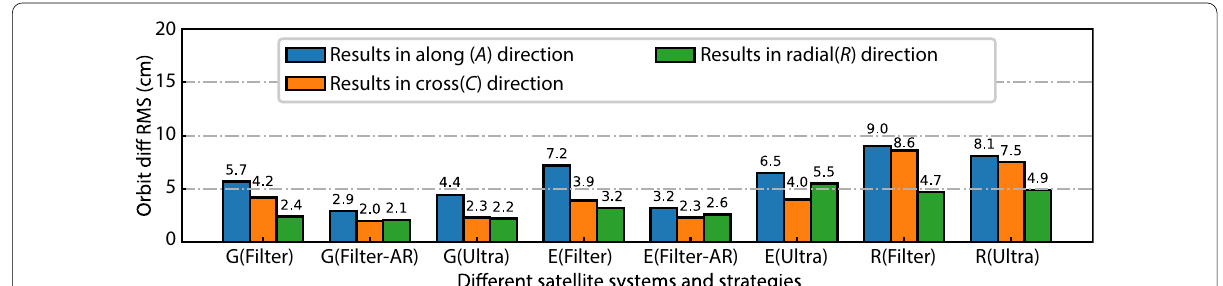
Fig. 5 Average orbit accuracy of filtering solutions and ultra-rapid products for GPS, Galileo, and GLONASS satellites compared with the final products of CODE from DOY 061 to 072, 2021. The 1–2 h predicted part of ultra-rapid products from WHU (wum) are used for comparison. The symbols of G, E and R refer to GPS, Galileo and GLONASS, respectively. The symbols of ‘Filter’, ‘Filter-AR’ and ‘Ultra’ mean the orbit products of filter solutions without AR, the orbit products of filter solutions with AR and the ultra-rapid orbit products, respectively (Table 5)